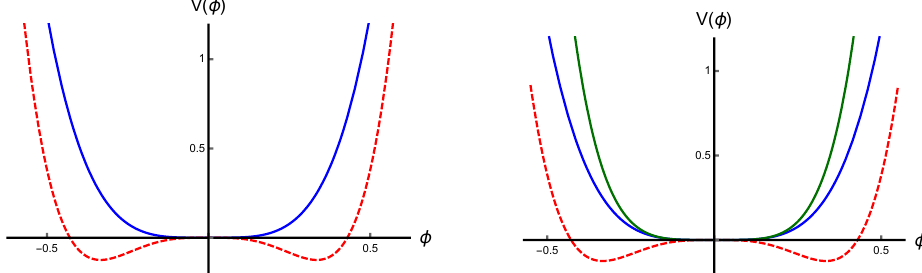
Figure 1 . Effective potential with the one-loop (left) and leading all-loop (right) radiative